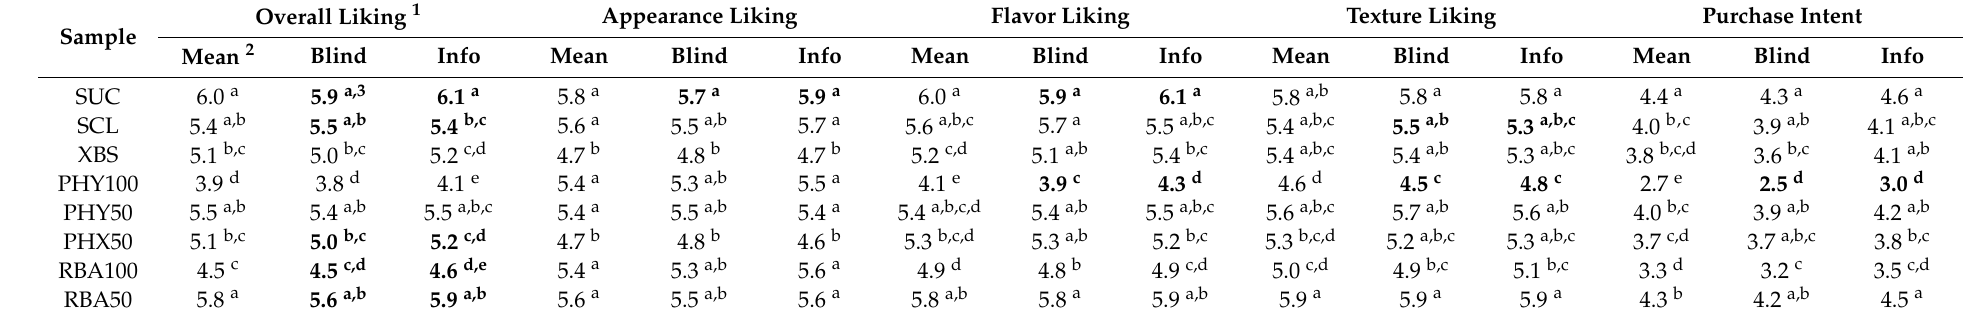
Table 7. Mean score of consumer liking and purchase intent for eight cookie samples under different information